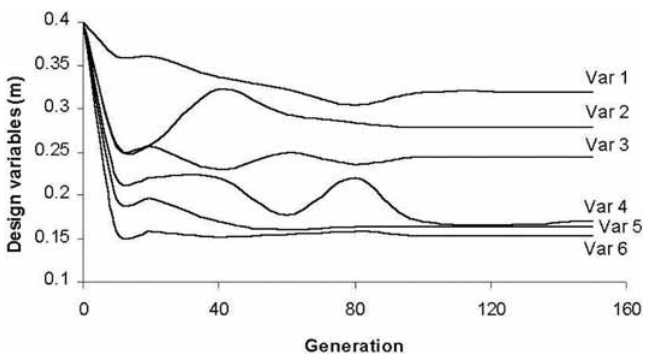
Fig. 9. Plot of design variables vs. number of generations (cantilever